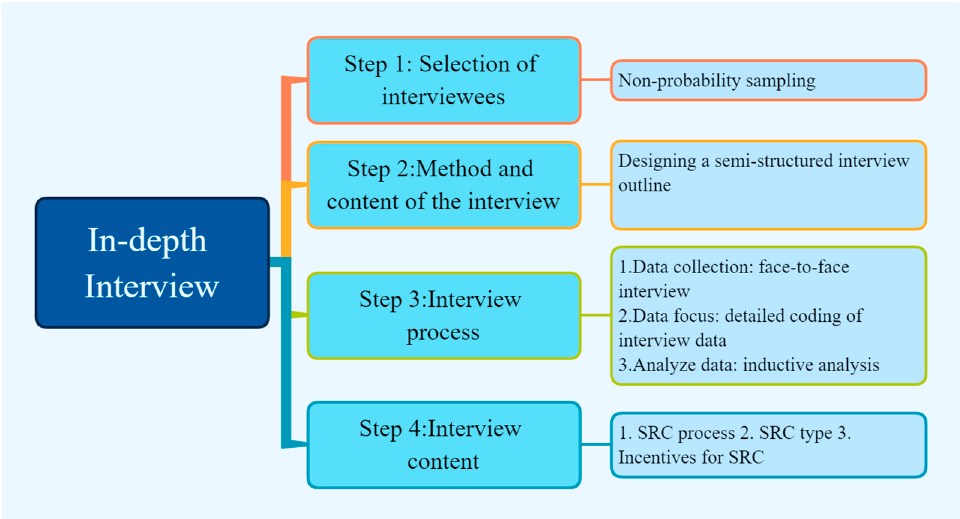
Figure 3. Interview procedure.